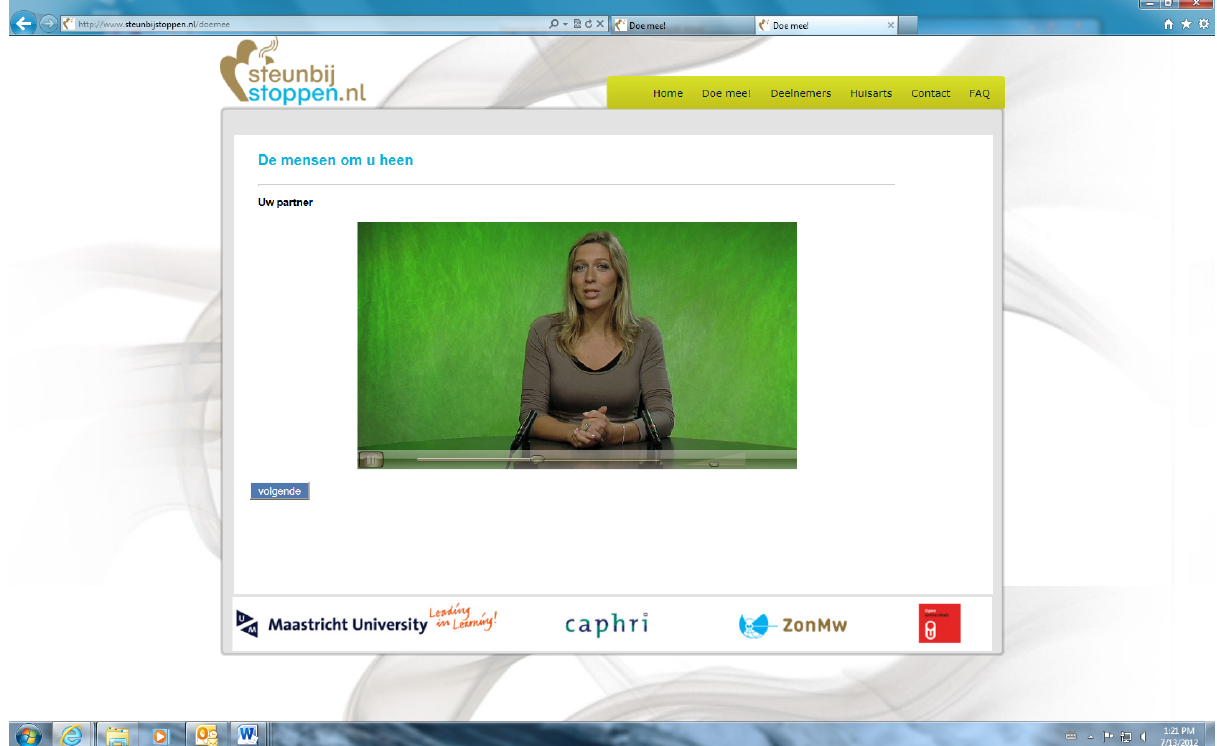
Figure 2. Screenshot of personal advice from the video